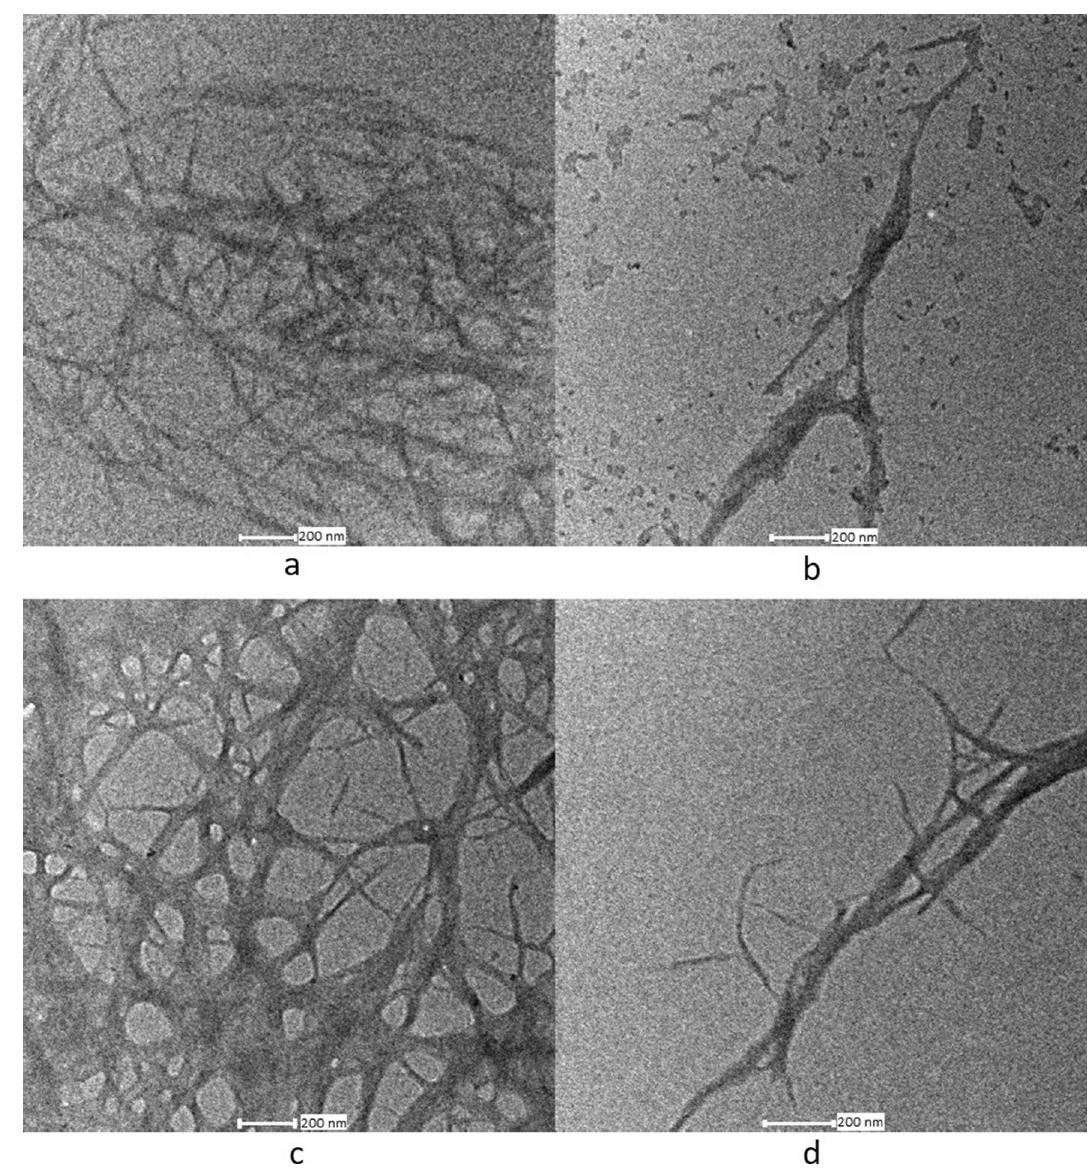
Figure 1. TEM images of ( a and b ) Eucalyptus tereticornis and ( c and d ) Casuarina equisetifolia wood